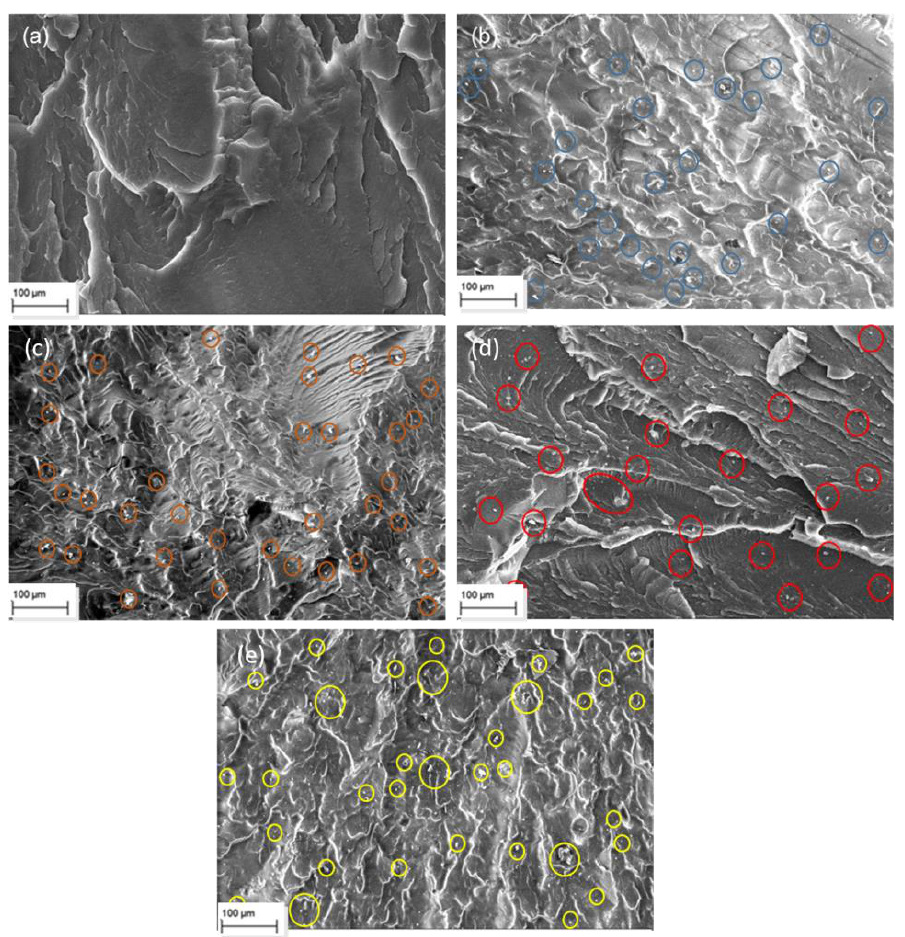
Figure 4. SEM images of ( a ) neat LDPE; ( b ) LDPE with 2.5 wt% OBM slurry; ( c ) LDPE with 5 wt% OBM slurry; ( d ) LDPE with 7.5 wt% OBM slurry and ( e ) LDPE with 10 wt% OBM slurry. The resulting spectra from the ATR-FTIR analysis of the OBM waste slurry and its solid contents are presented in Figure 5.